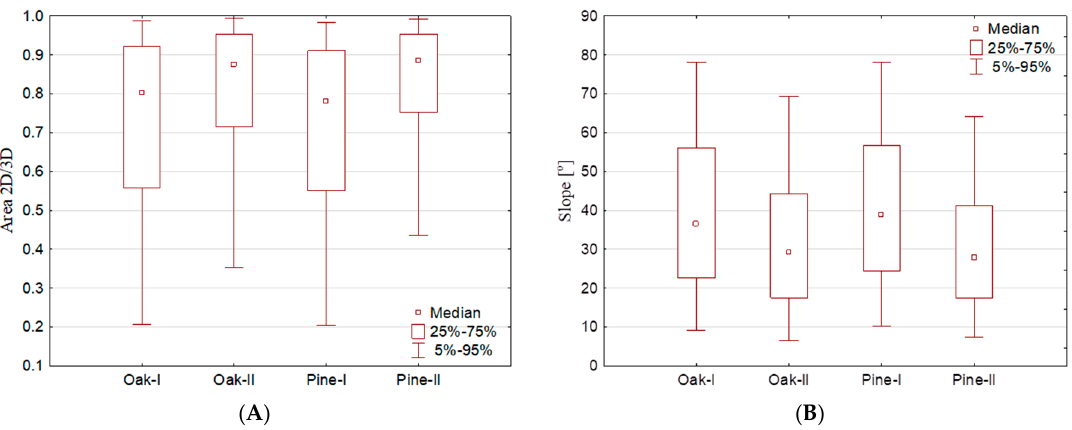
Figure 7. Statistical analysis of 2D/3D area ratio ( A ) and slope ( B ) for oak and pine tree trunks.